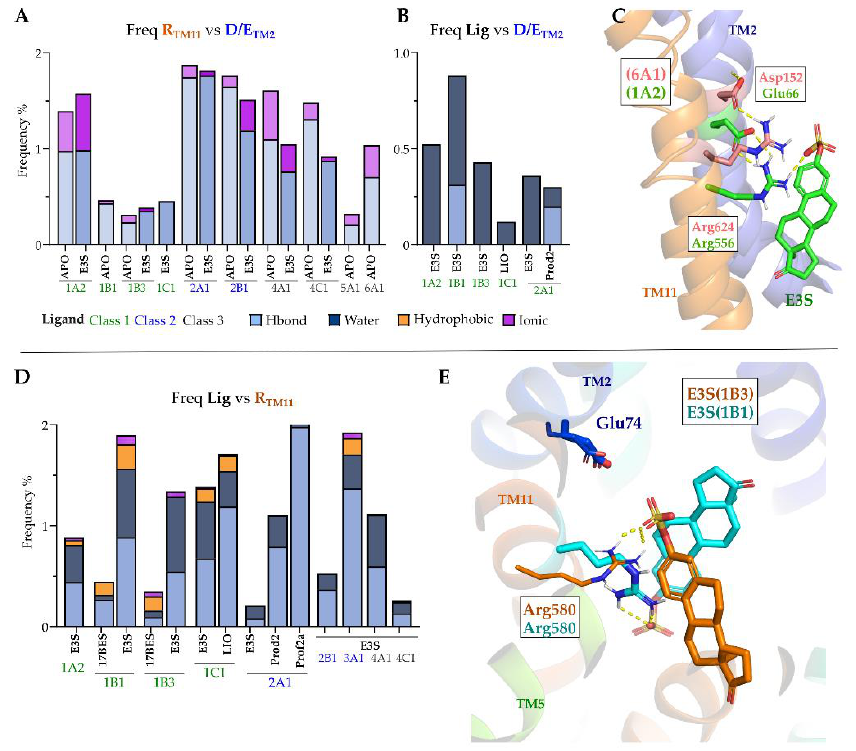
Figure 8. ( A ) Interactions between Arginine on TM11 and Glutamate or Aspartate on TM2 observed during MD simulations. ( B ) Interaction frequency of ligands with Glu/Asp on TM2. ( C ) Represen- tation of interactions between Arginine (TM11) and Glu/Asp (TM2) in OATP1A2 (green) and OATP6A1 (light pink). ( D ) Interaction frequency of ligands with Arginine on TM11. ( E ) Binding poses of E3S in OATP1B1 (cyan) and OATP1B3 (orange) showing interactions with Arginine on TM11.